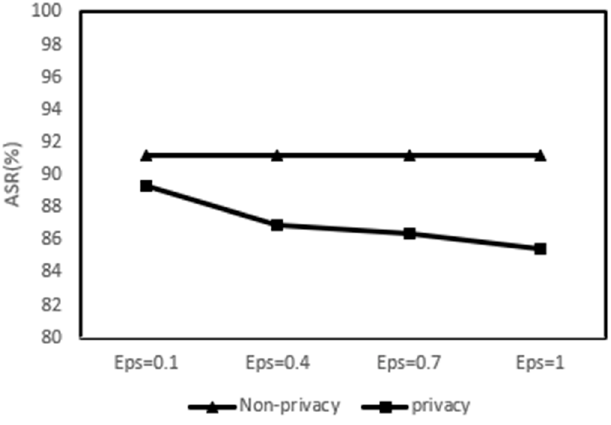
Figure 3. Assignment success rate (ASR) of non-privacy framework and our privacy framework.